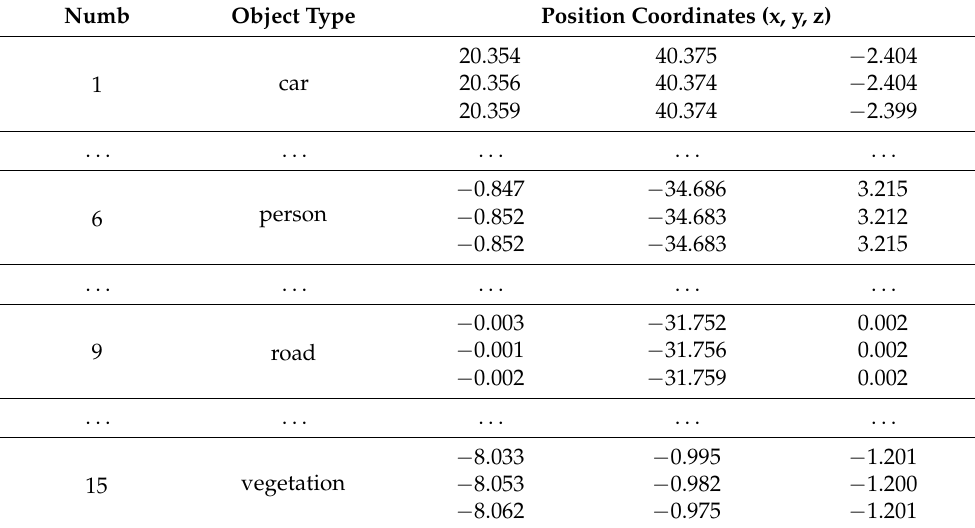
Table 5. The form after data